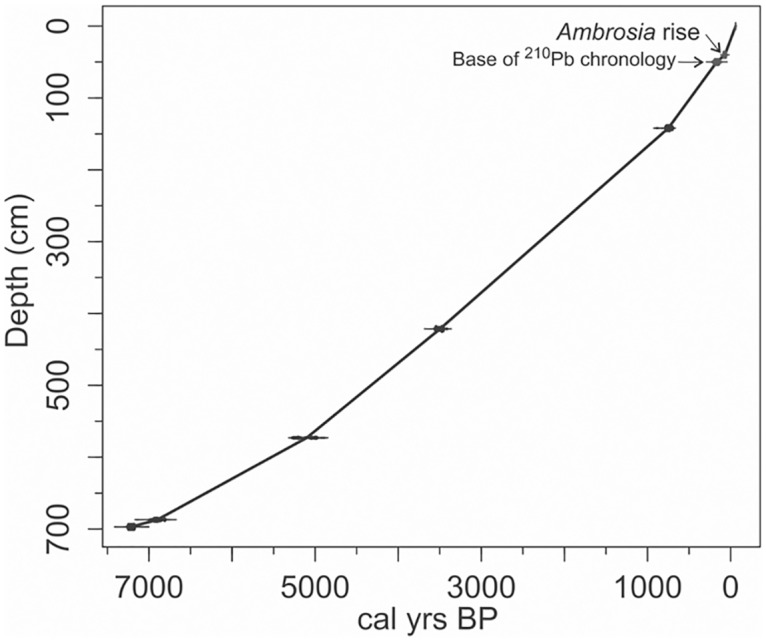
Age-depth model for the Wishart Lake sediment record.The model was developed using a linear regression model fit to calibrated radiocarbon dates, recent chronological data points derived from the Ambrosia pollen rise (depth 40 cm) and activity of 210Pb (lower boundary used, depth 50 cm). Radiocarbon dates (the five lowermost points) are shown with histograms corresponding to the probability distribution of calibrated dates [53]. Figure generated using clam for R [53].